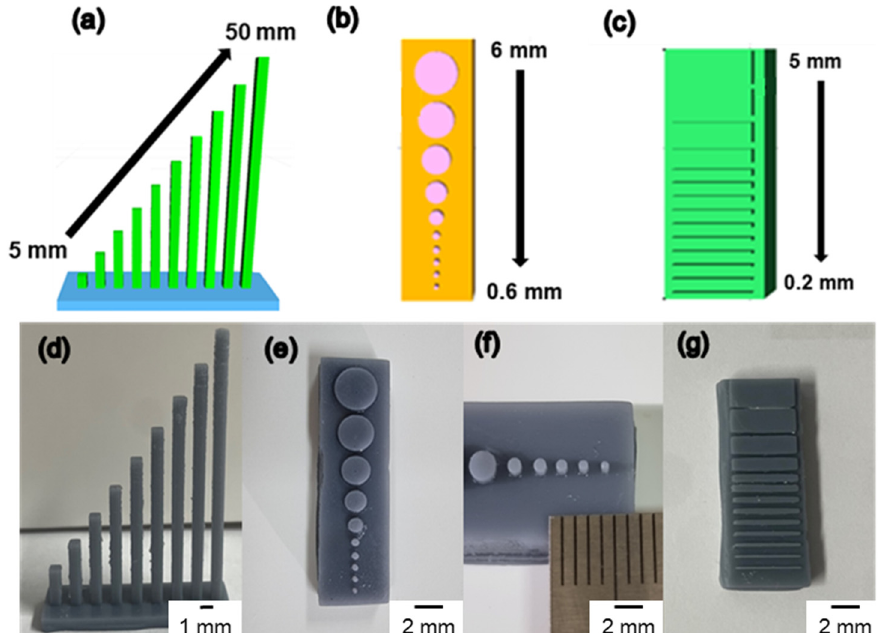
Figure 9. Comparison of resin resolution based on CAD photograph. ( a ) High-aspect-ratio column pattern. ( b ) Circle pattern. ( c ) Line pattern. Three structure patterns were printed with a 3D printer using a gray color resin. ( d ) Column structure (aspect). ( e ) Circle structure (front). ( f ) Magnified image with a scale range of 0.6–1.0 mm. ( g ) Line structure (front).